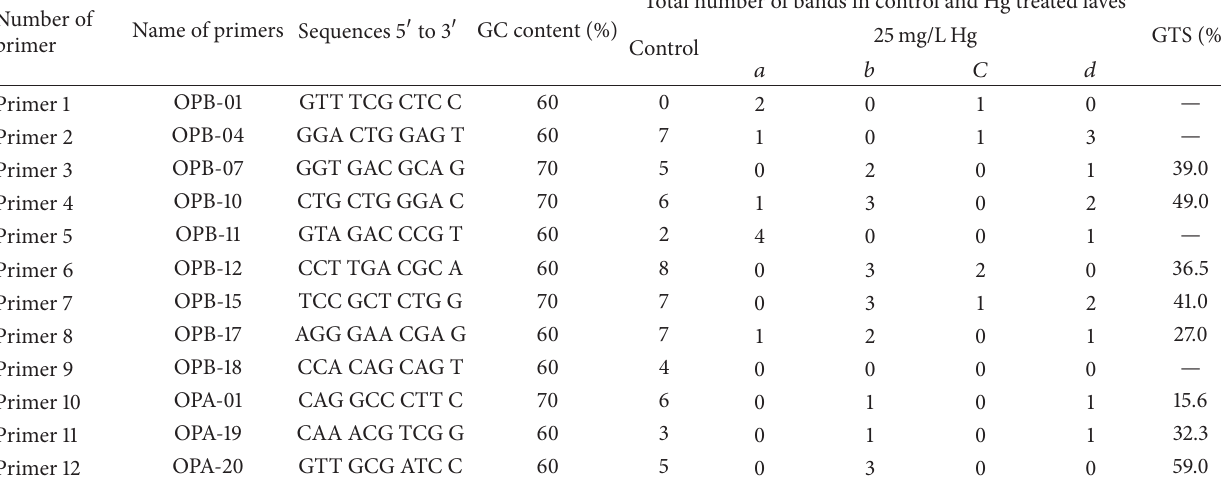
Table 3: List of RAPD primers, their sequences, GC content, changes of total bands, and genomic template stability (GTS %) in control and Hg treated leaves of M. arvensis